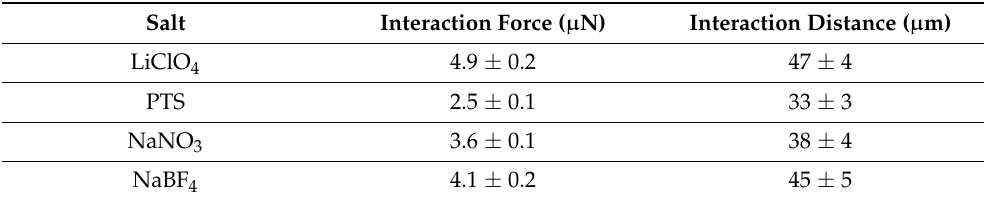
Table 3. Repulsive force and distance measured at pH 2 for different counter-ions used during the pyrrole